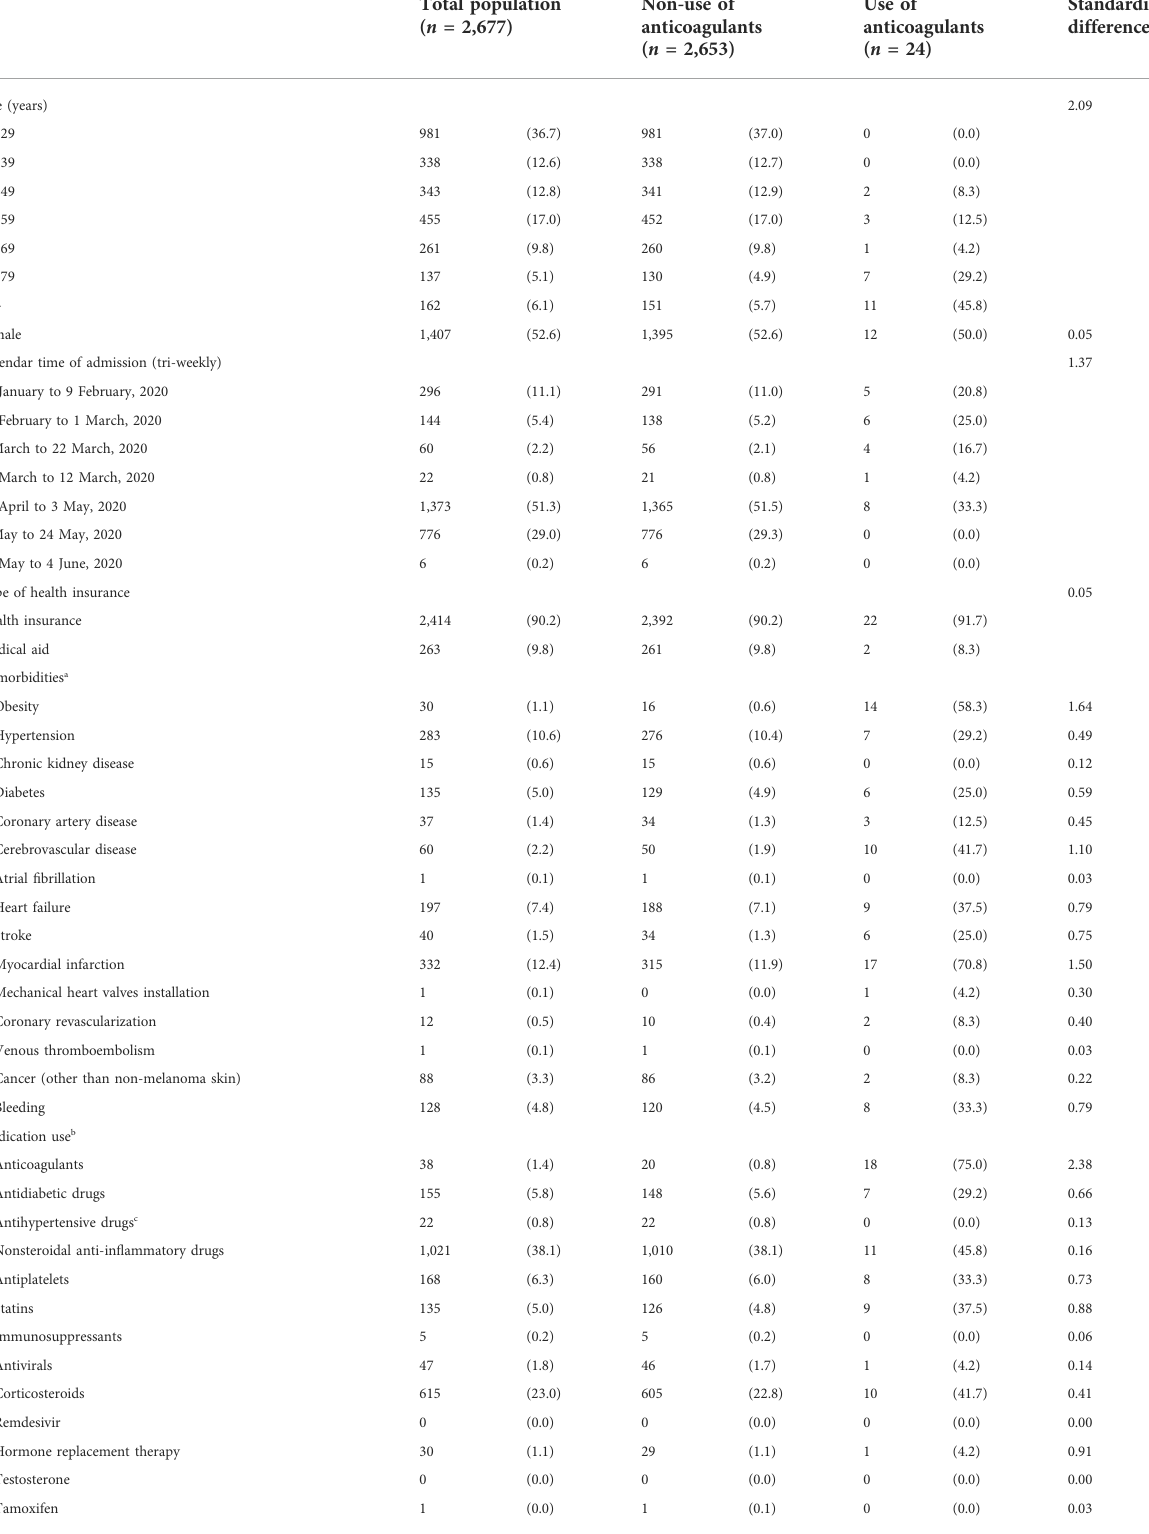
TABLE1Baselinecharacteristics ofCOVID-19hospitalizedpatientsinSouthKoreabetween20Januaryand4June,2020,byuseofanticoagulantsat